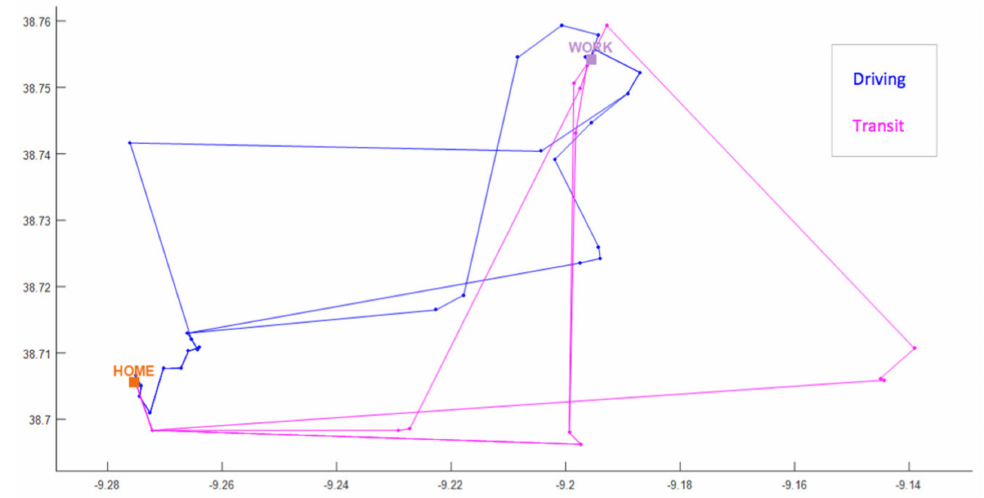
Figure 2. Route choices drawn with the received waypoints information from the Google Maps Directions